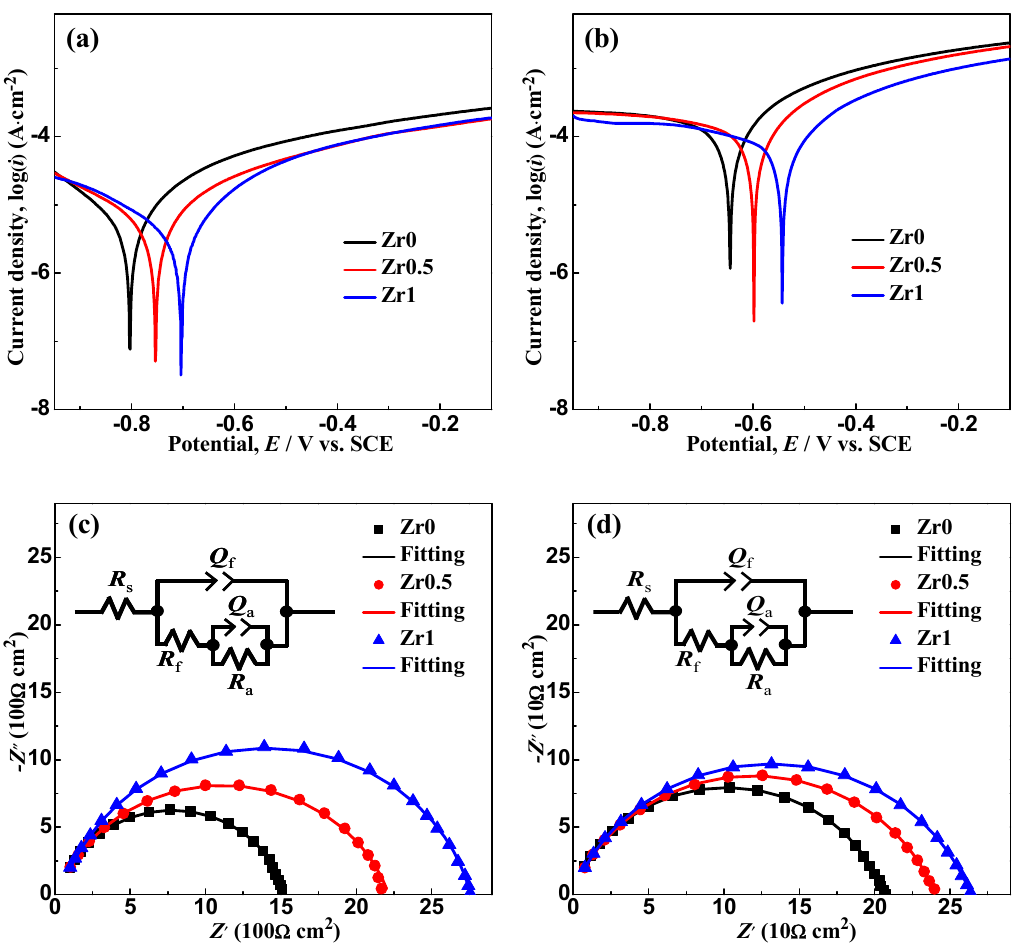
Figure 5. Polarization curves of the as-spun Zr0, Zr0.5 and Zr1 ribbons in ( a ) DW and ( b ) MB solution ( T = 298 K, pH = 3, C H2O2 = 1 mM and C MB = 100 mg L − 1 ) and their Nyquist curves in ( c ) DW and ( d ) MB solution. The insets in ( c , d ): the general fitted circuit. Symbols show the experimental data while solid lines are fitting